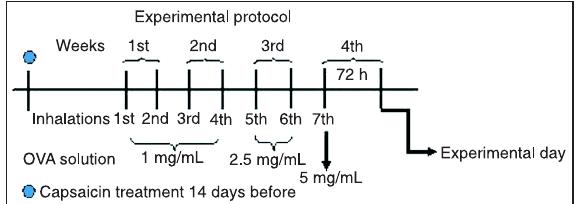
Figure 1. Timeline of the experimental protocol. Fourteen days before the beginning of the sensitization protocol, guinea